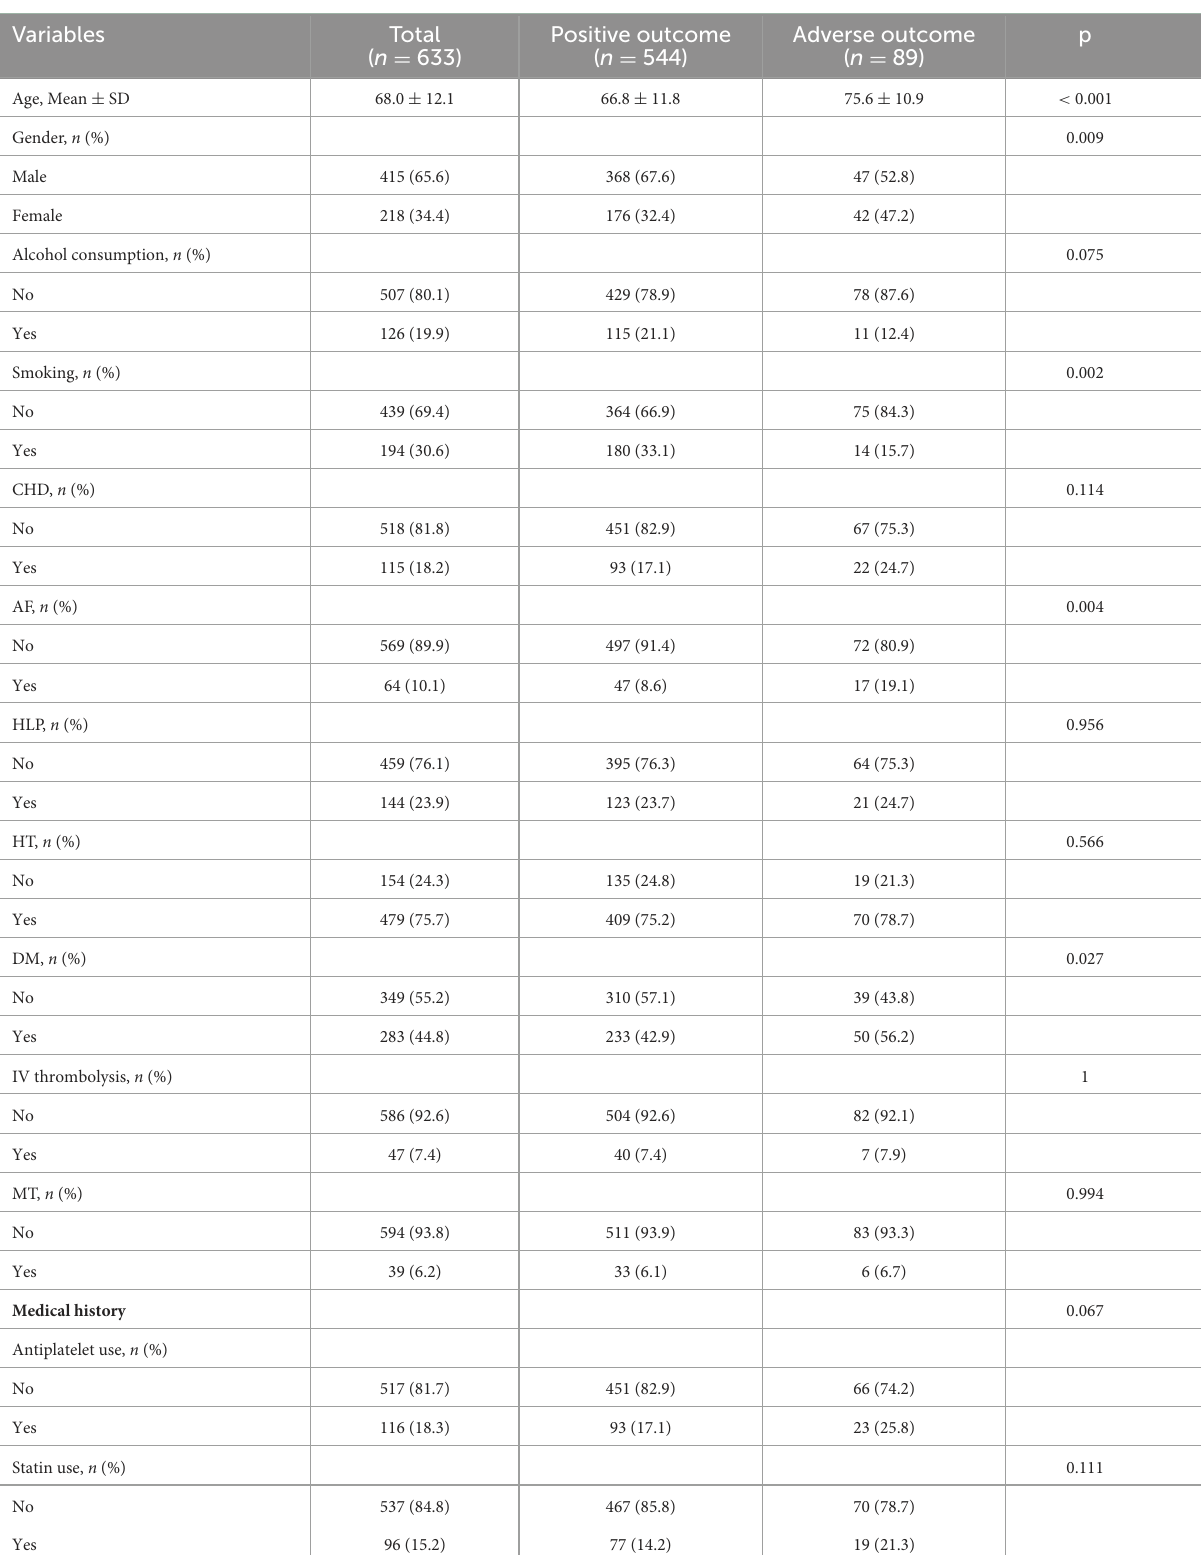
TABLE 1 Comparison of baseline characteristics according to functional status within 3